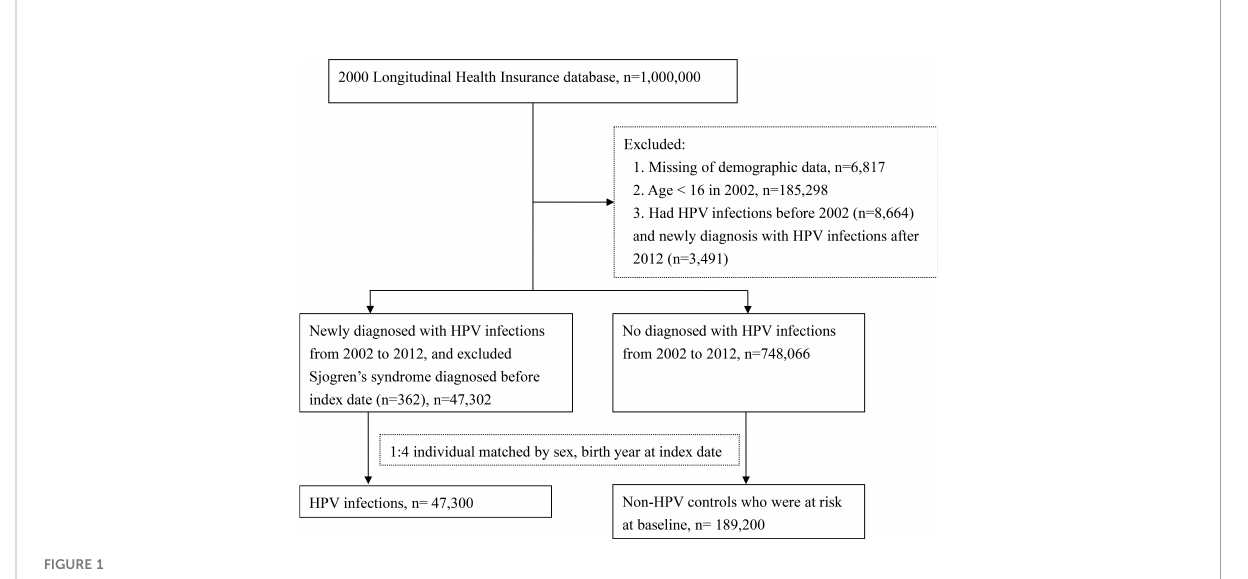
FIGURE 1 Flowchart for study